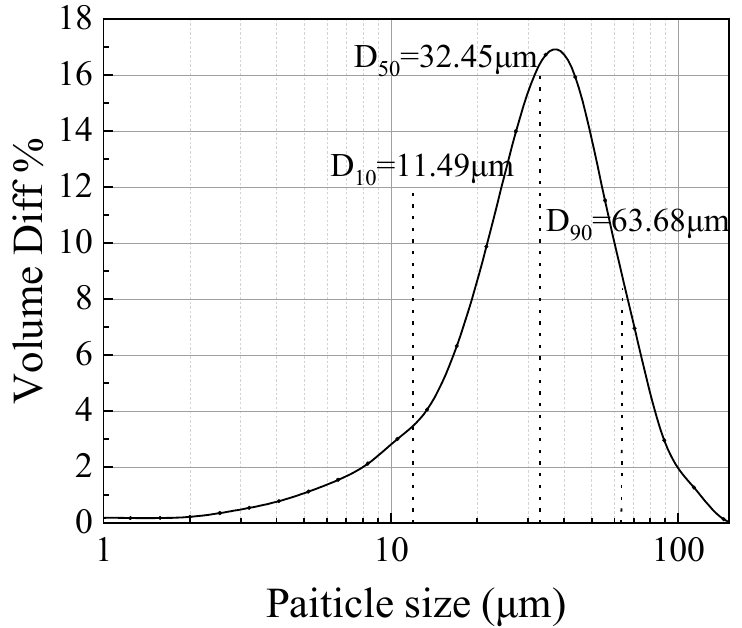
Figure 1. An example of particle size distribution (the control powder). (D10: 11.49 µm, D50: 32.45 µm, D90: 63.68 µm).